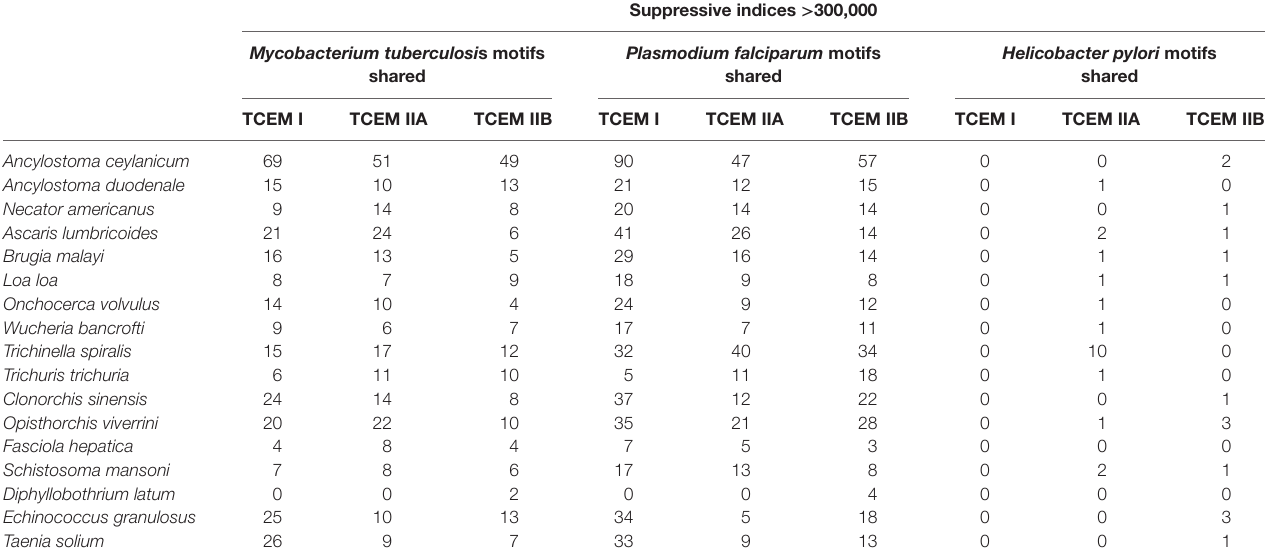
Table 4 | Sharing of helminth T-cell-exposed motifs (TCEMs) associated with extremely high suppressive index motifs with selected co-infections. suppressive indices > 300,000 Mycobacterium tuberculosi s motifs Plasmodium falciparum motifs Helicobacter pylori motifs shared shared shared